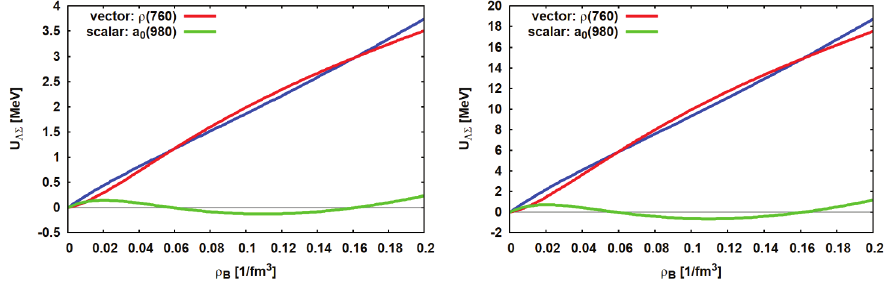
Figure 4. Density dependence of the Λ – Σ 0 in–medium mixing potential in nuclear matter with Z / A = 0 . 4 and in pure neutron matter, Z / A = 0. The scalar (green) and vector (red) components are shown together with the full mixing potential (blue) as de fi ned in Eq.(4)